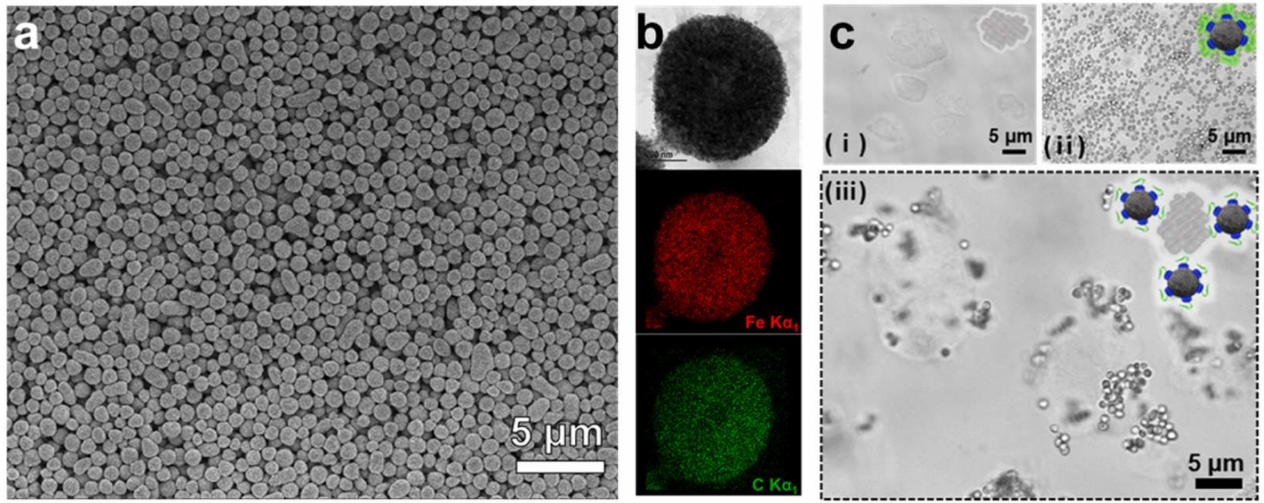
Figure 2. ( a ) Scanning electron microscope (SEM) and ( b ) transmission electron microscopy- energy dispersive x-ray spectroscopy (TEM-EDX) image of SBP-MBP@SMMBs. Elemental iron (Fe) and carbon (C) are represented as red- and green- dots, respectively. ( c ) Transmitted light microscopy of SiO 2 (i), SBP-MBP@SMMBs (ii) and mixture of SiO 2 and SMP-MBP@SMMBs that formed an affinity-based complexation (iii) in aqueous